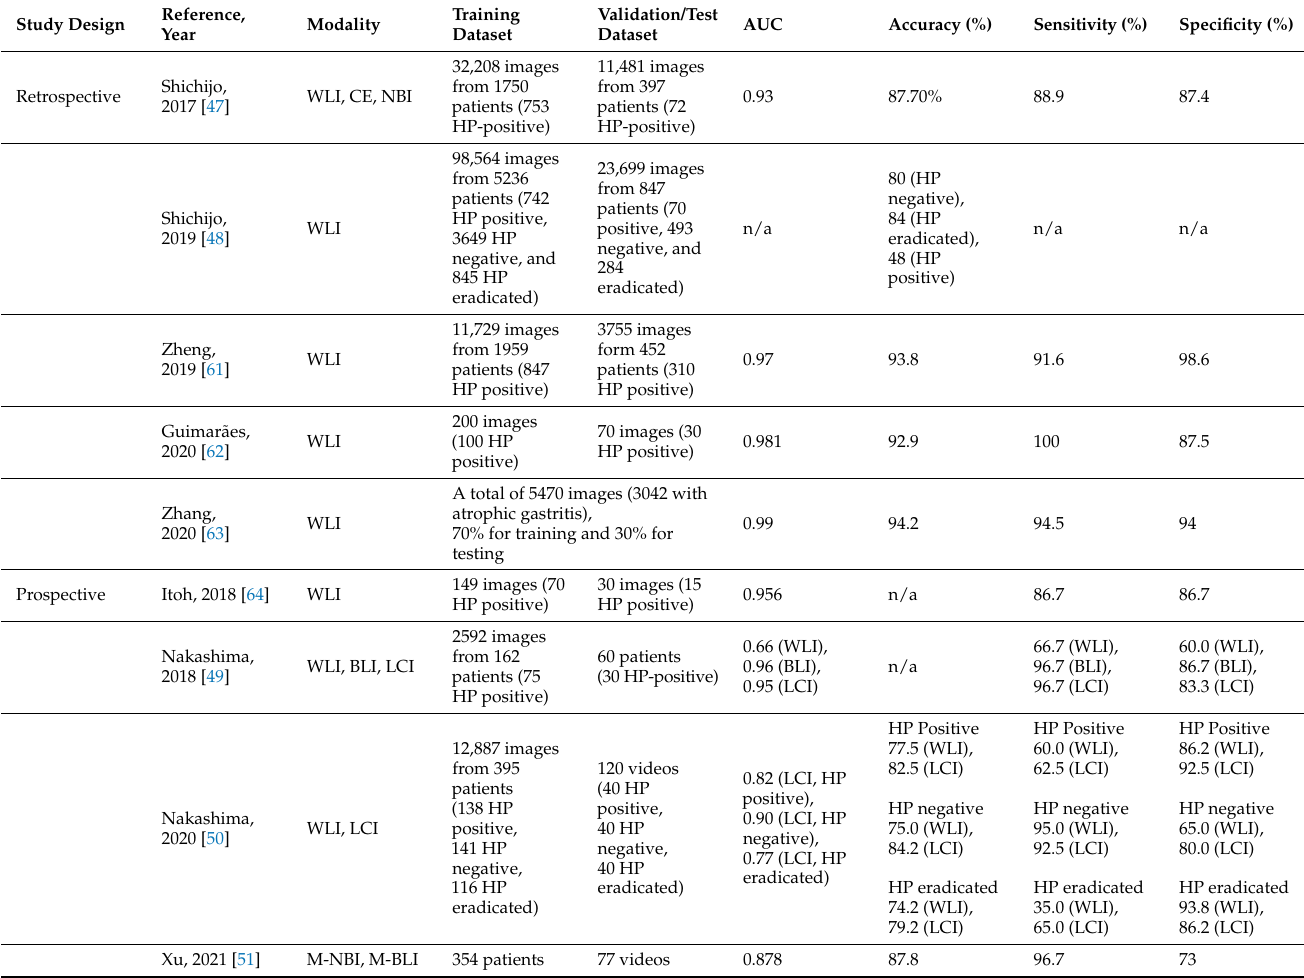
Table 3. Summary of CADx for Helicobacter pylori